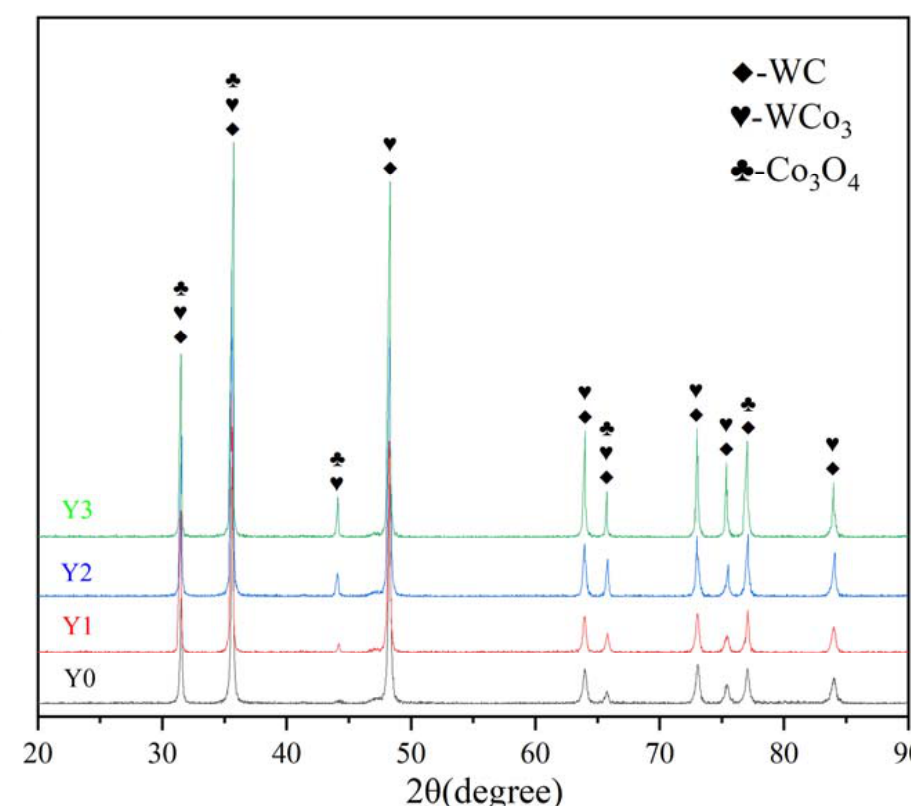
Figure 9. Surface XRD analysis of cemented carbide samples with different degrees of corrosion.